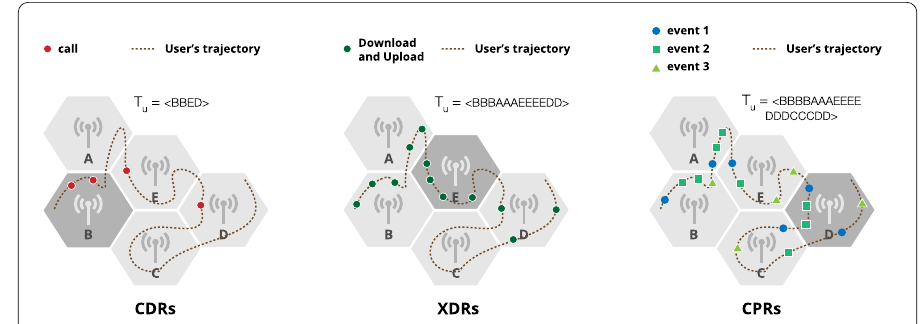
Figure 1 Illustrative example of Call Detail Records (CDRs), eXtended Detail Records (XDRs) and Control Plane Records (CPRs) of a user u . The hexagons represent mobile phone towers and black dots the positions where the user starts a call (CDRs), a download/upload operation (XDRs), or a network event (CPRs). Red dots indicate calls, green dots indicate download/upload operations, blue dots, green squares and green triangles indicate network events. The dotted line indicates the real movement of the user, from the left to the right, within each panel. The dark grey tower indicates the tower in which the user has the highest number of records. From this example, we observe that: 1) CDRs are the most sparse and CPRs the most dense data stream; 2) when u does not perform any call or download/upload operation in the area covered by a tower, there is no information about the user’s position in CDRs and XDRs; 3) CPRs is the only type of records that can describe all the towers u passed through